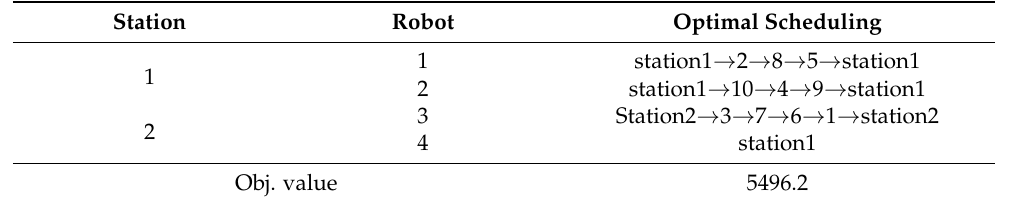
Table 2. Optimal schedule of SR.